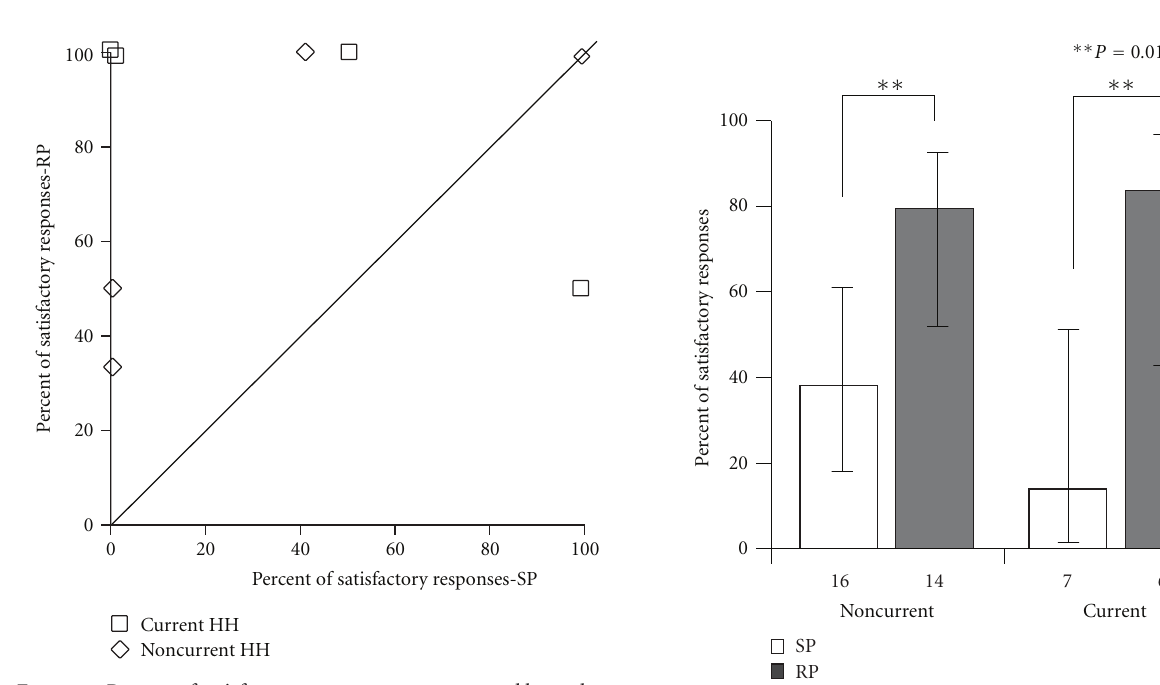
Figure 6: Percent of satisfactory responses to unexpected blindside hazards for current and noncurrent drivers. Both current and noncurrent drivers had better responses in the real prism (RP) than the sham prism (SP) condition, suggesting that the use of the peripheral prisms improved detection of blindside hazards for current drivers as well as noncurrent drivers. Numbers under each bar are the total number of hazards in each condition. Error bars represent 95% confidence